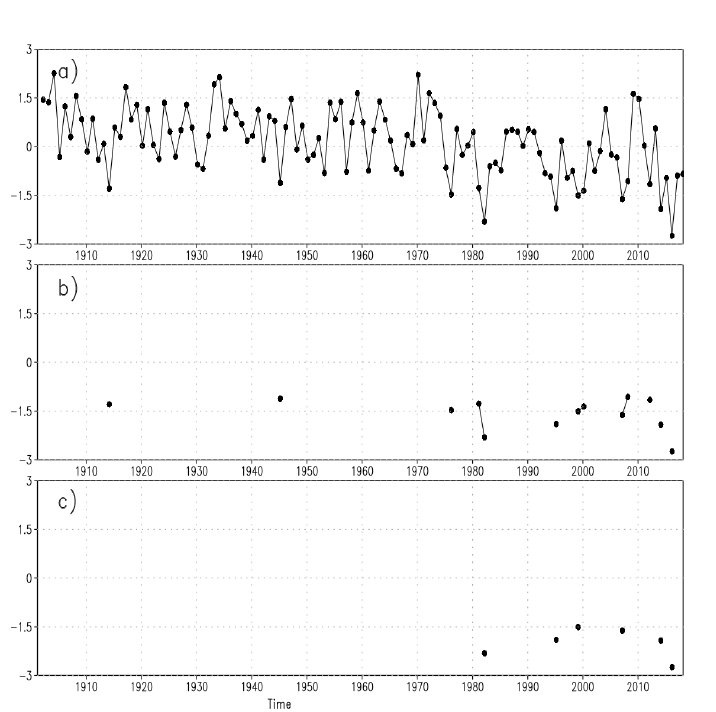
Figure 2. Time series of SPEI-6 March values from 1901 to 2018 at location 37.00 ◦ N, 2.25 ◦ W of Iberian peninsula: ( a ) value for March of each year; and ( b , c ) only the values belonging to Drought and Severe+Extreme classes, respectively. The connecting lines in ( b , c ) identify two consecutive episodes occurred in the same